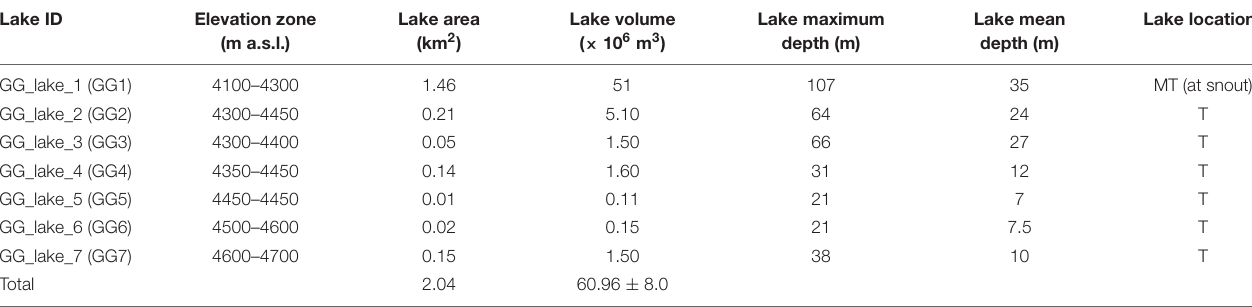
TABLE 2 | Physical attributes of the identified potential sites of future lake formation in the Gepang Gath Glacier. Lake ID Elevation zone (m